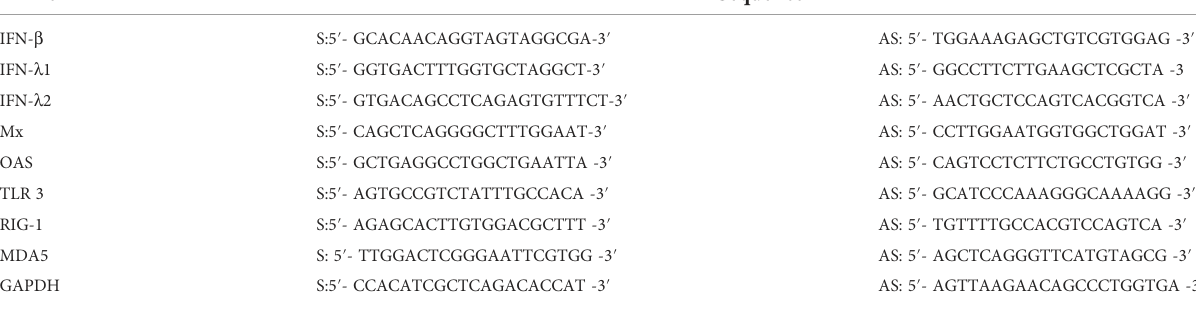
TABLE 1 Primers used for real time PCR